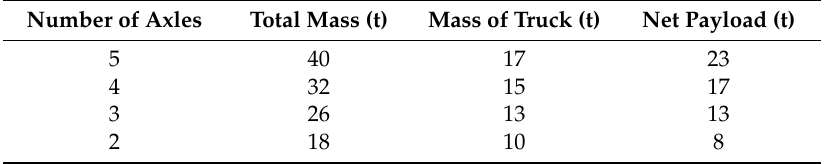
Table 1. Main mass characteristics of different truck types used in hauling timber